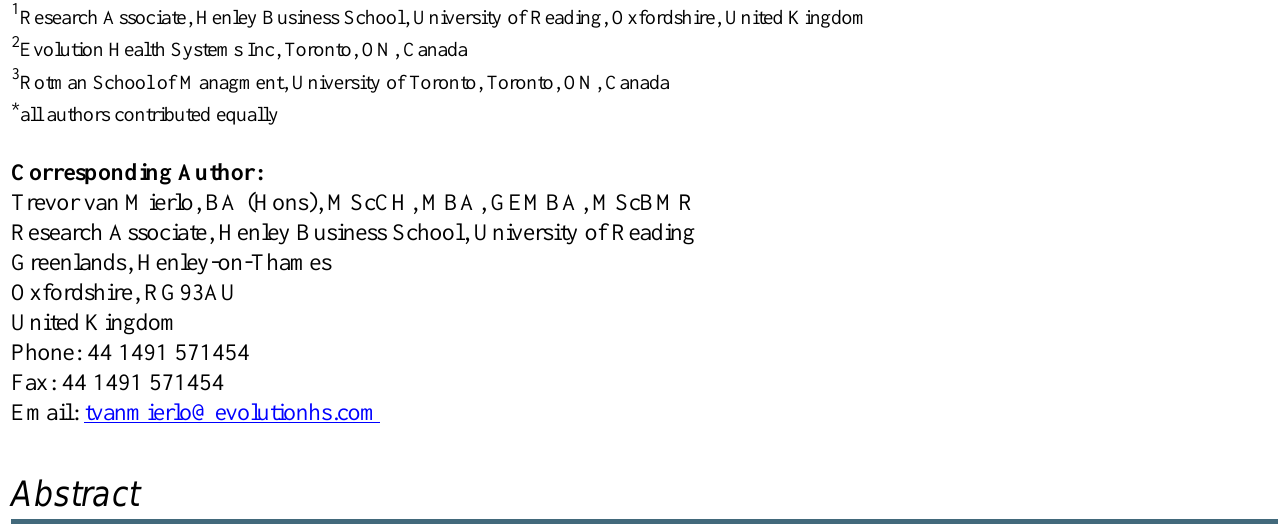
social networks; eHealth; 1% rule; Pareto Principal; power law; 90-9-1 principle; moderated support; peer-to-peer